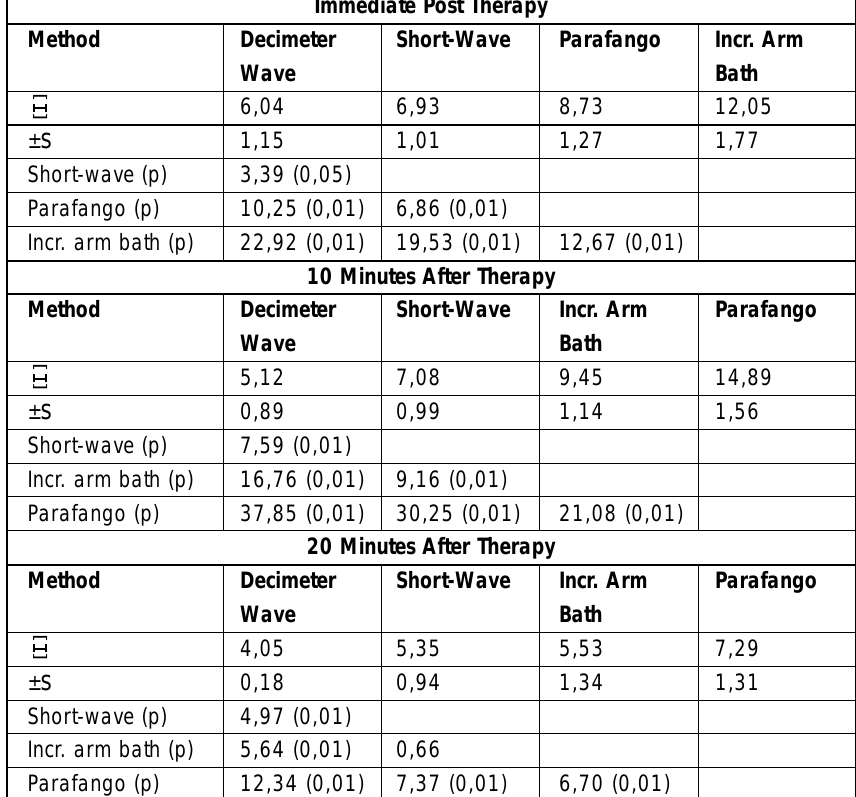
Table 4: Mean value comparisons (Newman-Keuls-test) of the consensual reaction of the circulation at defined intervals within the healthy